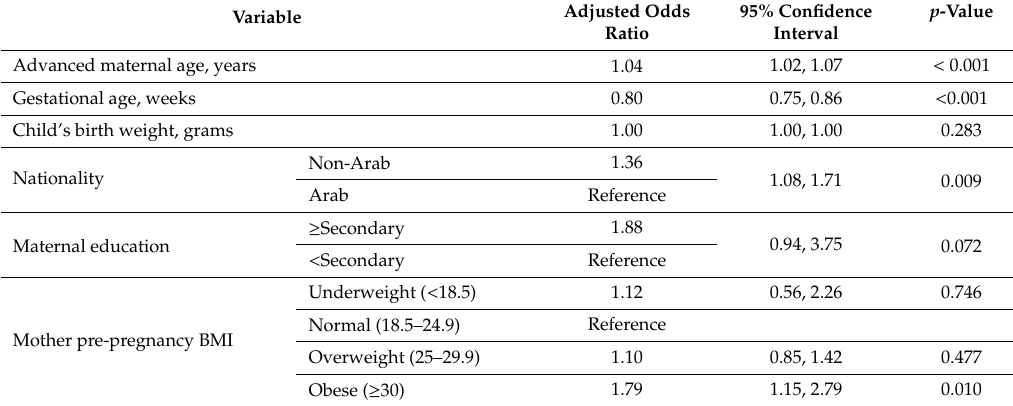
Table 2. Multivariable logistic regression analyses of factors associated with caesarean section among mothers with children two years old and younger in Abu Dhabi, UAE.